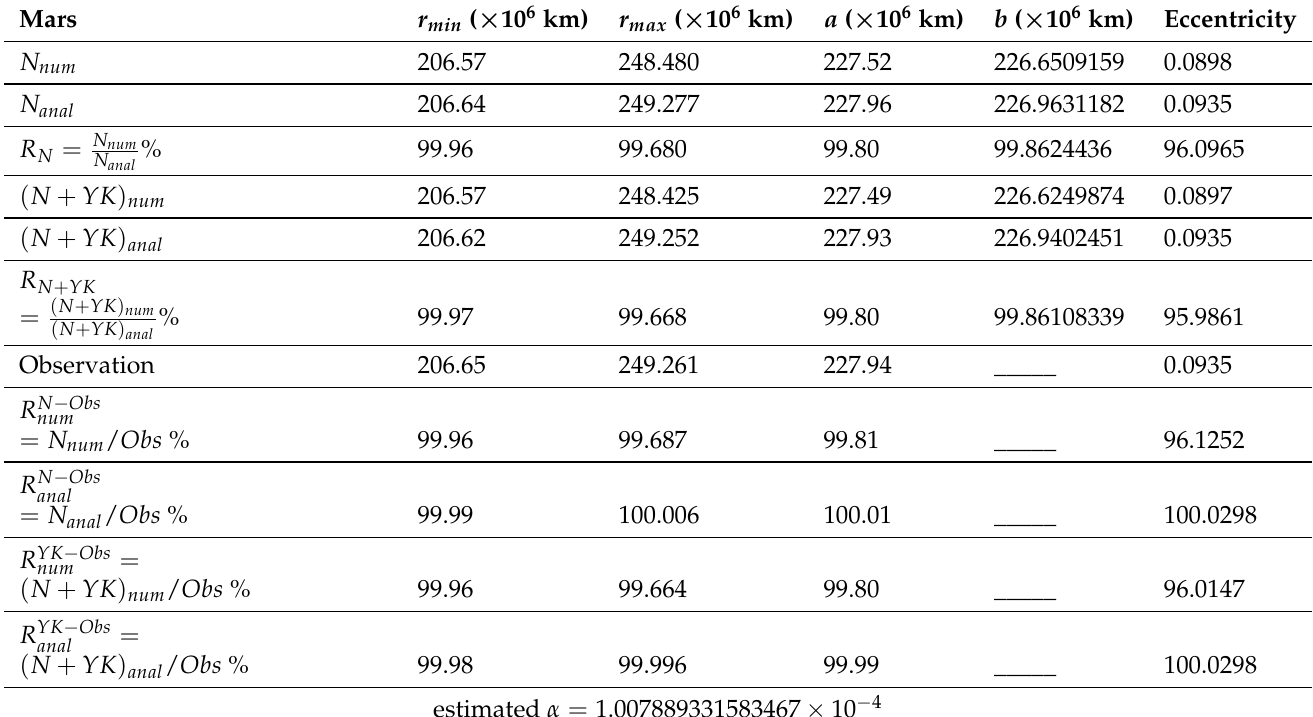
Table A8. The values of the calculated and observational astronomical parameters, for estimated α , of the planet Mars, whose number of moons is 0.